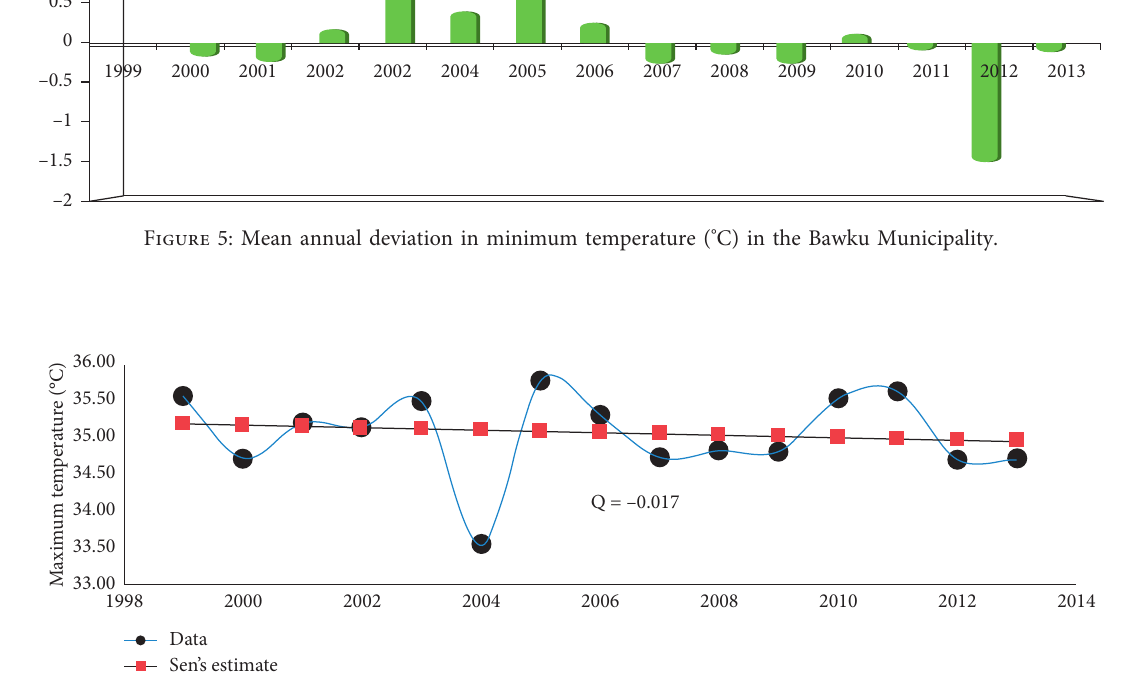
Figure 6: Mean annual trend in maximum temperature in the Bawku Municipality.